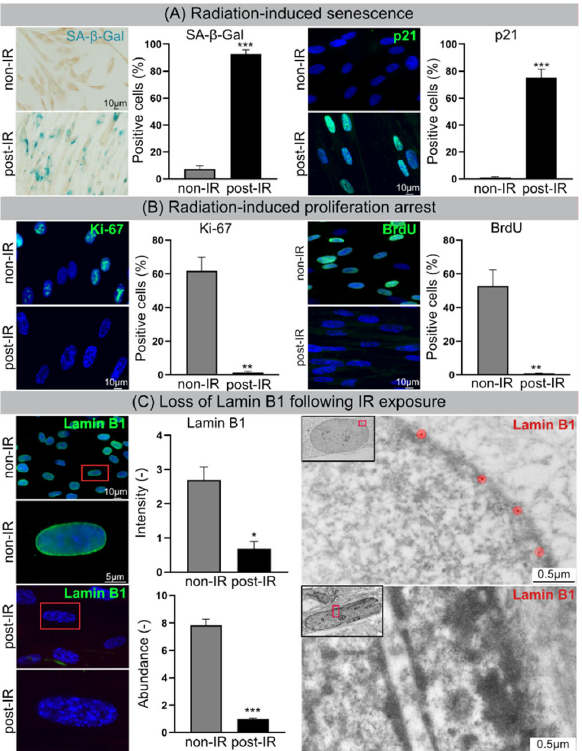
Figure 1. Cellular senescence following IR. ( A ) Increased numbers of SA- β -Gal-positive and p21- positive cells following IR. ( B ) Decrease in Ki-67-positive and BrdU-positive cells. ( C ) Lamin B1 loss in nuclear envelope following IR exposure visualized by IFM (left) and TEM (right). Quantification of lamin B1 in WI-38 fibroblasts by IFM (top middle), and MS (bottom middle). Data are presented as mean ± SEM, * p < 0.05, ** p < 0.01, *** p < 0.001.